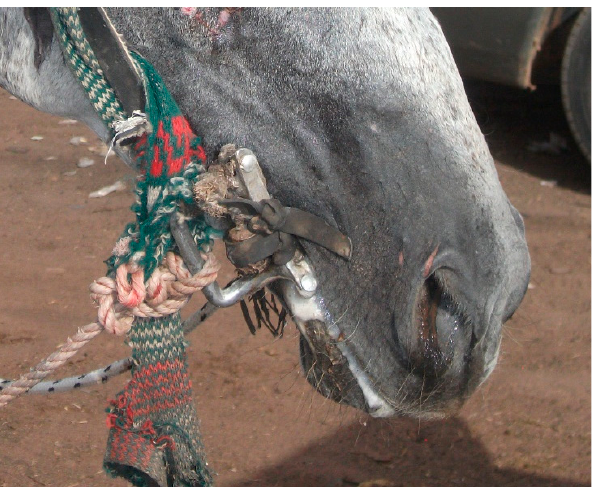
Figure 8. Locally produced bit in Senegal with cheek-pieces pressing against the equid’s face, and multiple knots and attachments which are a potential cause of discomfort, pressure and altered fit.